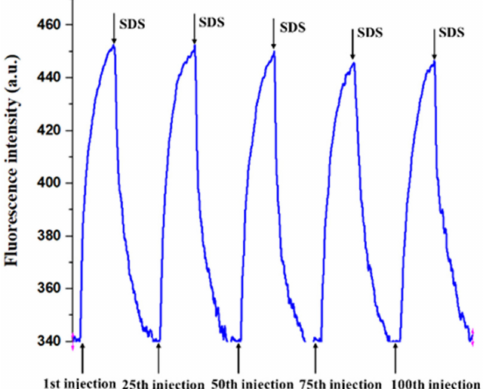
Figure 3. The fluorescence signal traces without DON using 0.25 µ g · mL − 1 Cy5.5-anti-DON-antibody for multiple immunoassays of the DON-BSA modified